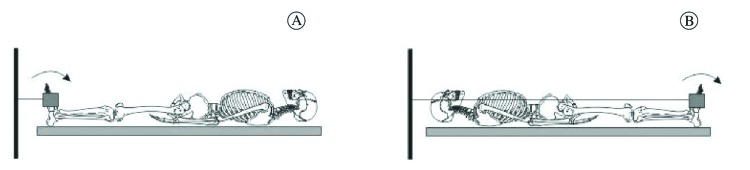
Schematic representation of the ankle during the perceived force level
test. Participants performed maximal isometric voluntary ankle dorsiflexion
(A) and plantar flexion (B), then contraction equivalent to 10% and 20% of
the maximal with visual feedback by numerical computer, and finally the
performances reproduced a target force.